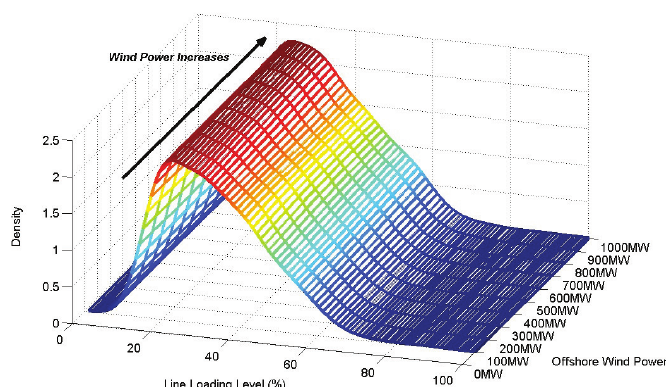
Figure 13. Wind power variability vs. probability density function of loading level in FirstEnergy/PJM transmission system.